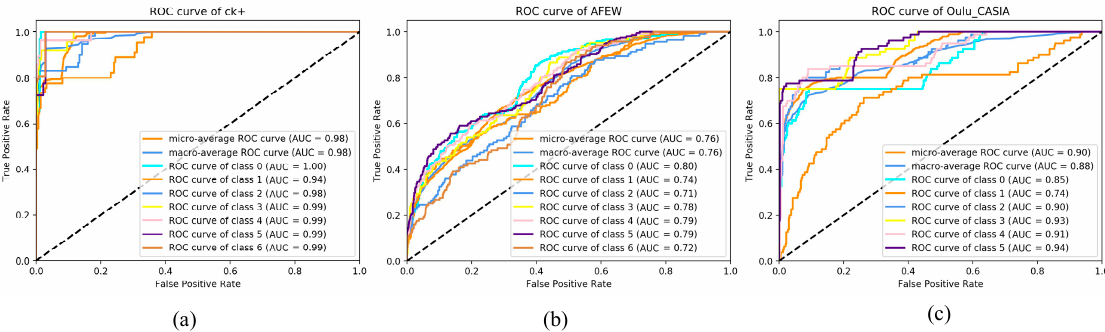
Figure 8. Multiclass receiver operating characteristic (ROC) curves and their area under the ROC curve (AUC) areas on CK+, AFEW, and Oulu-CASIA datasets. In each subfigure, there are either nine or eight lines plotted with different colors, including (i) two lines that represent the macro-average ROC curve and the micro-average ROC curve of the dataset, and (ii) either seven or six lines that represent the corresponding ROC curve for each expression in the dataset. To be specific, in the subfigure ( a ) (i.e., CK+ dataset), classes 0–6 correspond to the expressions of Happy, Anger, Disgust, Fear, Sadness, Contempt, and Surprise, respectively; In subfigure ( b ) (i.e., AFEW dataset), classes 0–6 correspond to the expressions of Happy, Angry, Disgust, Fear, Sad, Neutral, and Surprise respectively; in the subfigure ( c ) (i.e., Oulu-CASIA dataset), classes 0–5 correspond to the expressions of Anger, Disgust, Fear, Happiness, Sadness, and Surprise respectively.